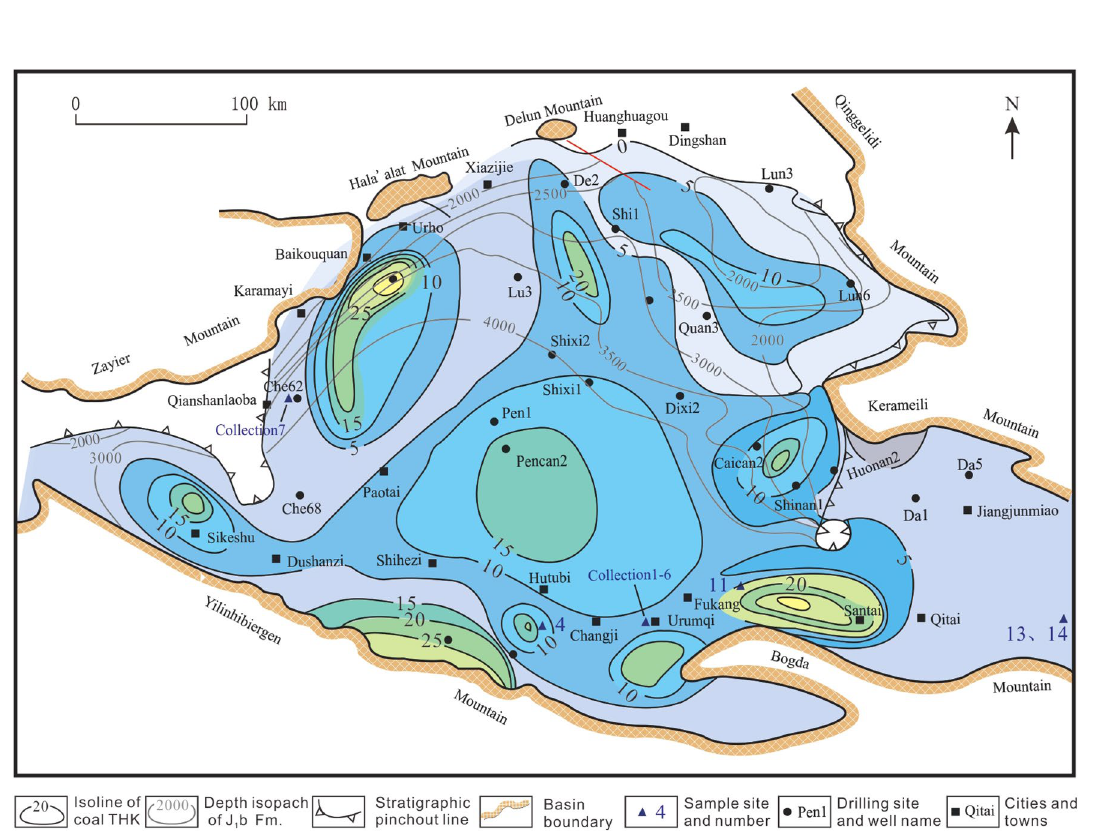
Fig. 3 Contour of thickness and buried depth of Badaowan Fm. coal reservoir in Junggar Basin (Unit in